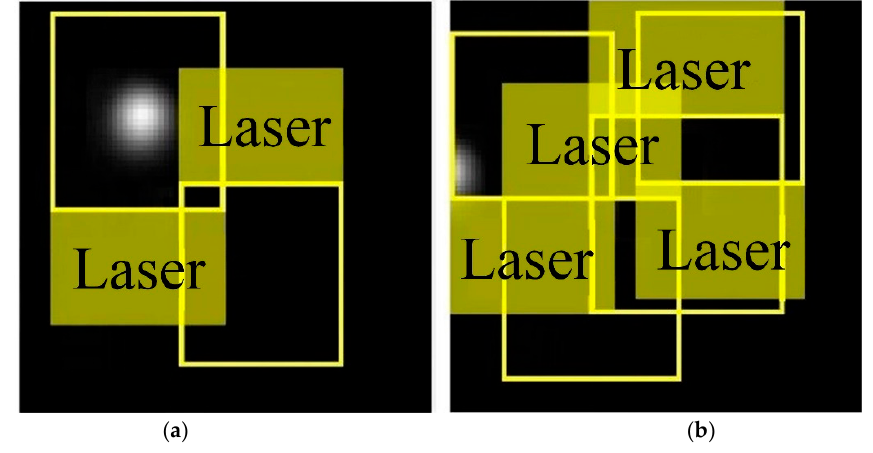
Figure 5. ( a ) Complete light spot map positioning (50 positive samples); ( b ) incomplete light spot map positioning (50 positive samples).